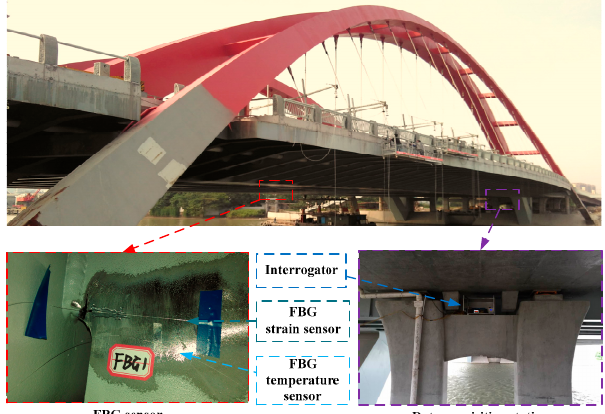
Figure 2. Deployment of FBG-based SHM system.